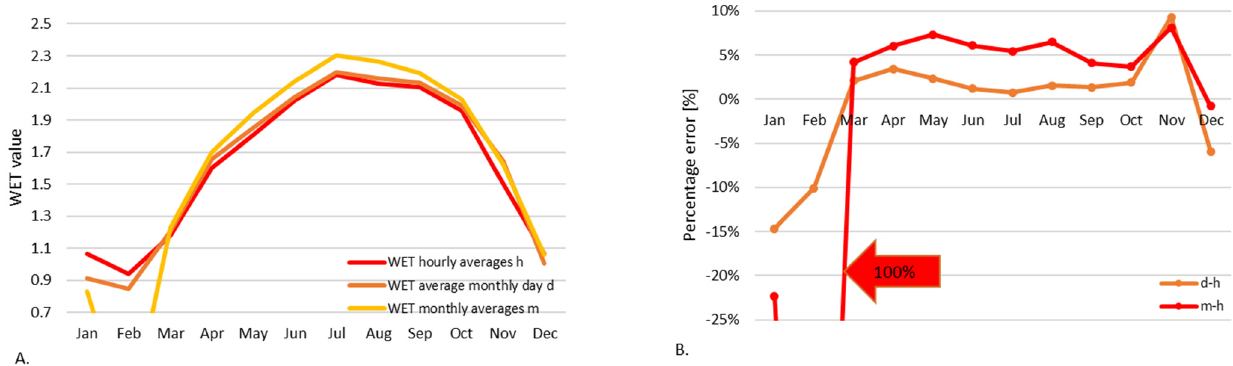
Figure 14. Rome WET values ( A ) and percentage error ( B ).